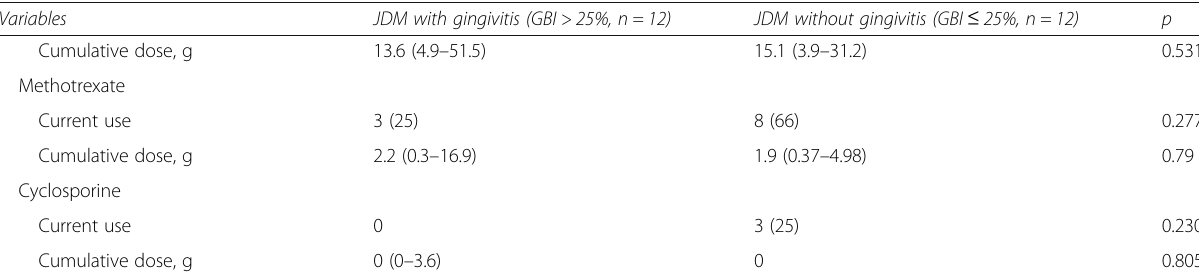
Table 3 Demographic and anthropometric data, body composition, laboratorial findings, juvenile dermatomyositis (JDM) scores and treatment in JDM patients with and without gingivitis (Continued)